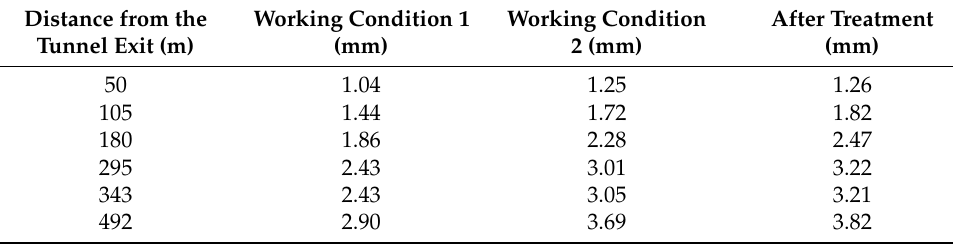
Figure 18. Displacement values of each point on the outside of the tunnel lining. Table 2. The maximum displacement of the